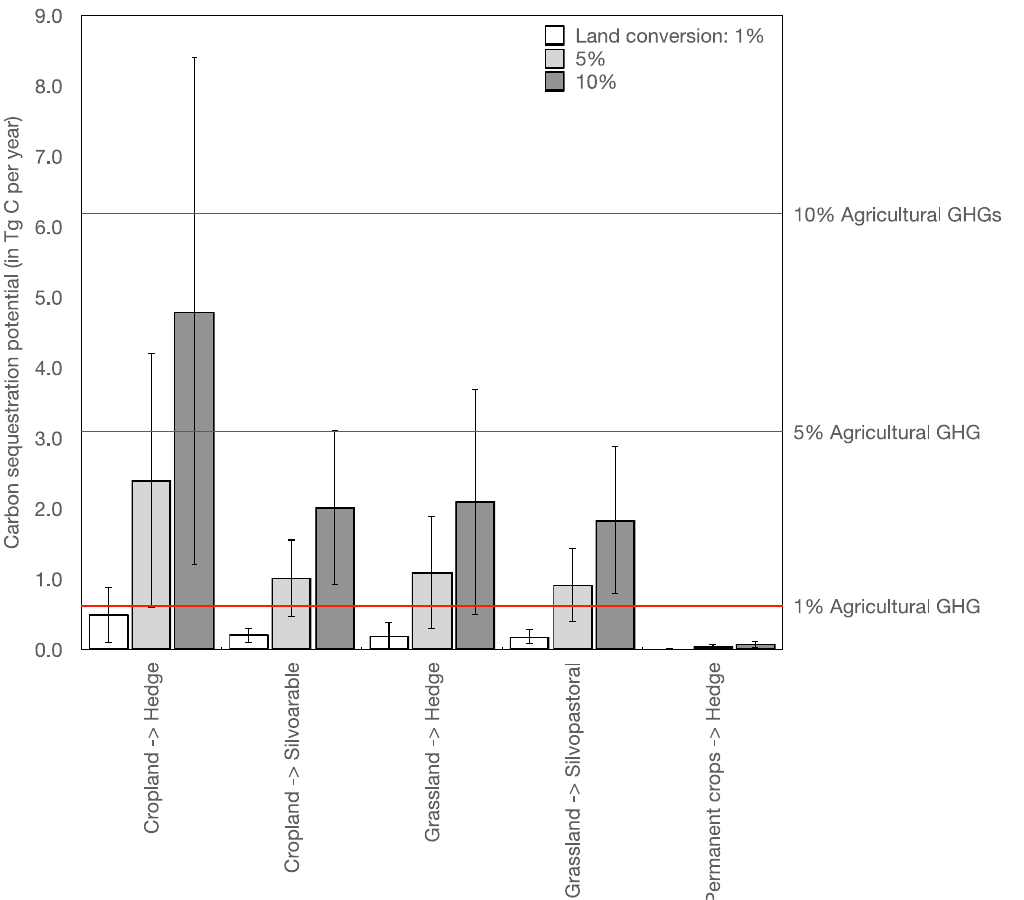
Figure 6. The potential of agroforestry systems to sequester carbon (in Tg yr − 1 ) according to three land conversion scenarios. Red lines denote the percentages of the 2019 agricultural GHG emissions baseline in Germany (61.8 Tg C yr − 1 ) for comparison purposes [5].